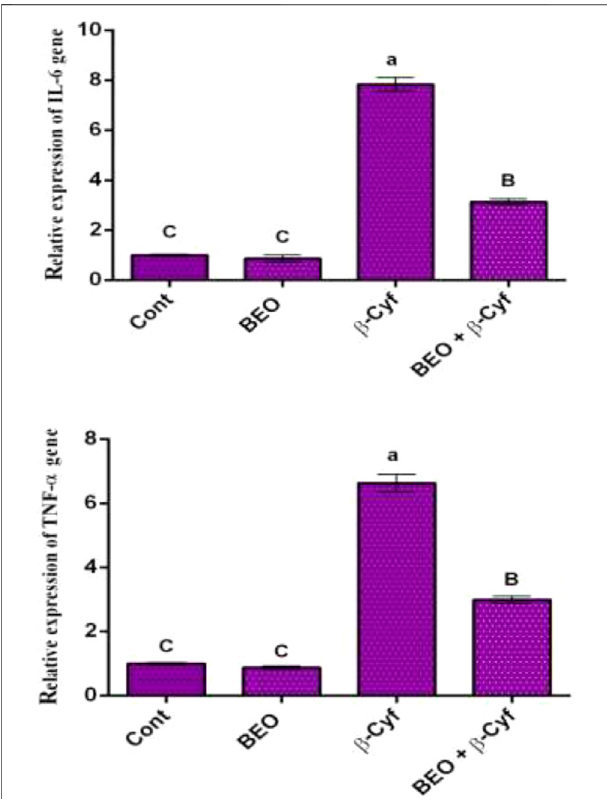
FIGURE4| Relativeexpressionof IL-6 andTNF- α genesinrats ’ livertissues ofdifferentgroups.Dataarepresentedasfoldchange(mean) ± SEM( n (cid:1) 7/group). Different letters show signi fi cant differences at p < 0.05. Groups are compared as follows: BEO and β – Cyfgroupsarecompared tothe negative controlgroup while BEO + β -Cyf group is compared to the positive control group, β